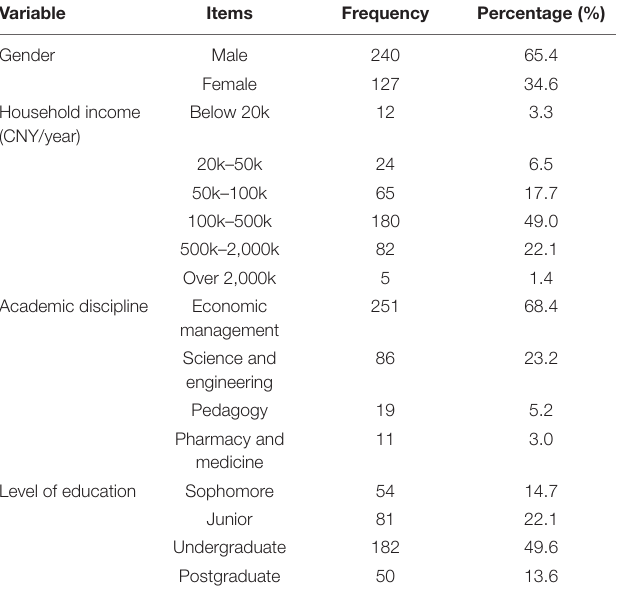
TABLE 2 | Basic information of